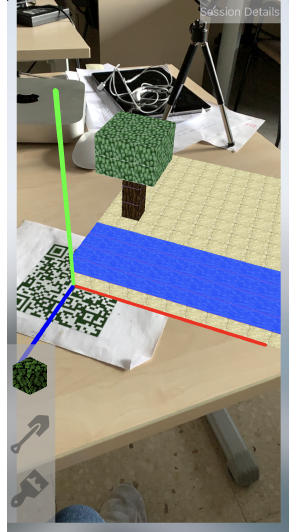
Figure 14. Capture of the voxel-based prototype taken from the iOS